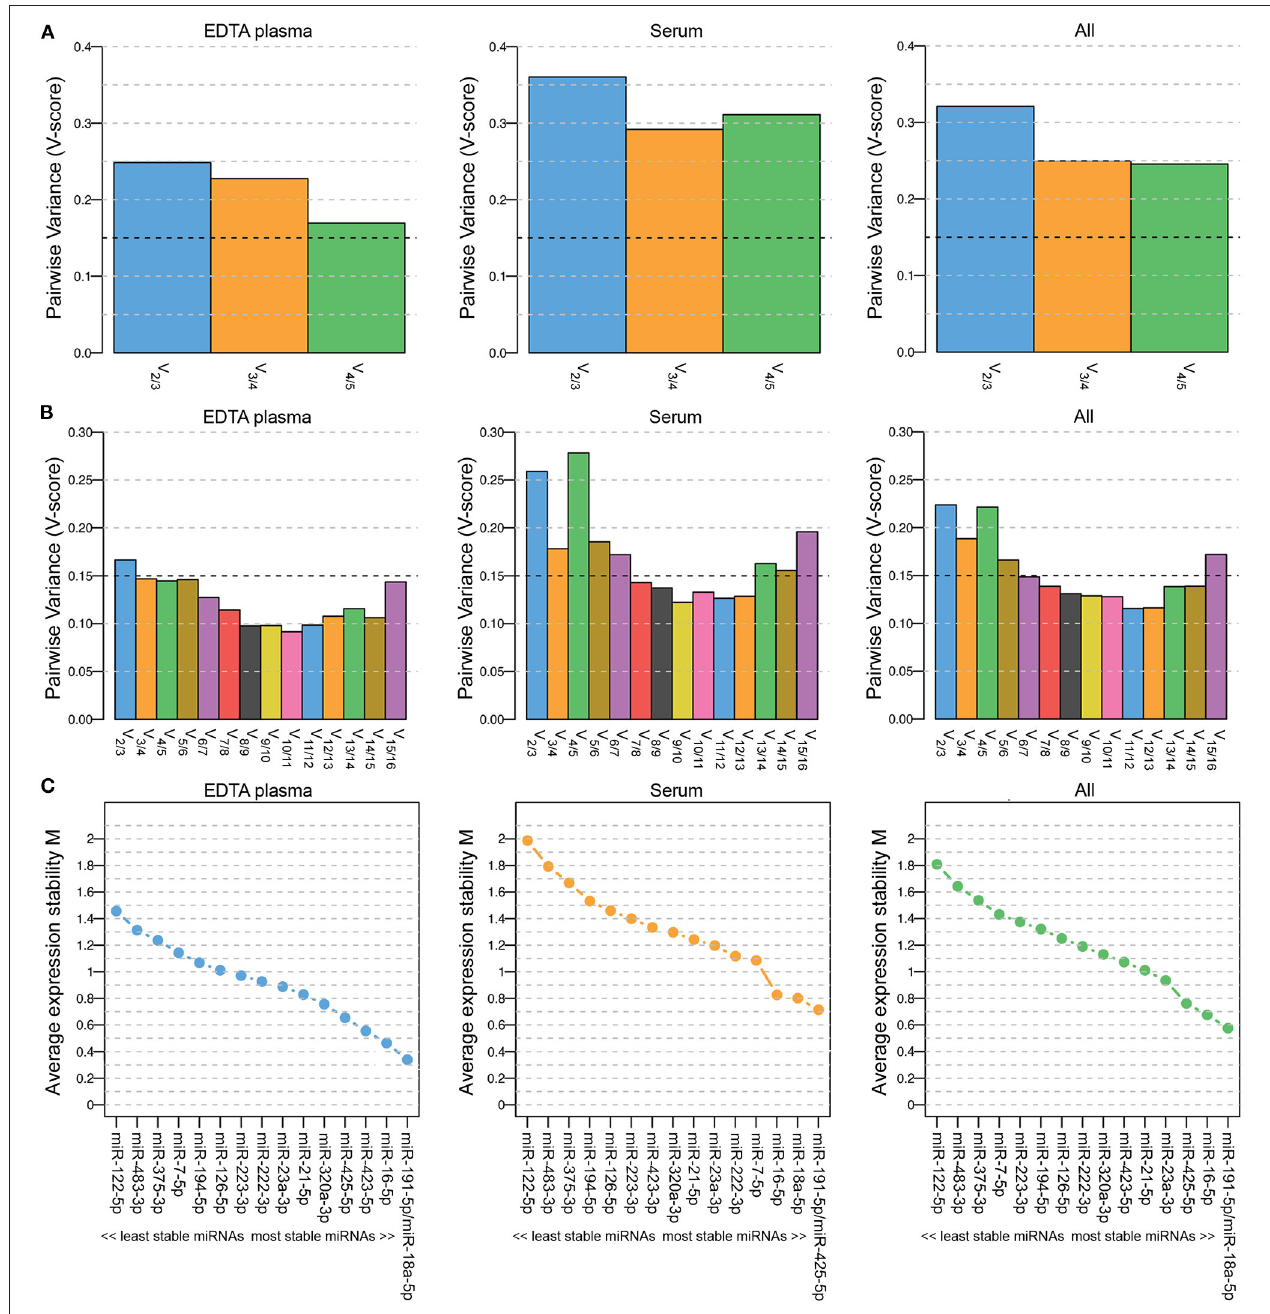
FIGURE 1 | Pairwise Variance (V-score) (A,B) and Average expression stability M (C) of miRNAs included in geNorm analyses to determine the optimal number of miRNAs for data normalization. Results when including 5 ( A ; miR-23a-3p, miR-191-5p, miR-222-3p, miR-423-5p and miR-425-5p) and when including 16 ( B,C ; miR-7-5p, miR-16-5p, miR-18a-5p, miR-21-5p, miR-23a-3p, miR-122-5p, miR-126-5p, miR-191-5p, miR-194-5p, miR-222-3p, miR-223-3p, miR-320a-3p, miR-375-3p, miR-423-5p, miR-425-5p and miR-483-3p) miRNAs. Left panels (EDTA plasma) include samples from healthy dogs ( n = 6) and from dogs with pituitary-dependent hypercortisolism ( n = 19, pre-op and post-op samples); middle panels (serum) include samples from healthy dogs ( n = 6) and from dogs with cortisol-secreting adrenocortical tumors ( n = 26); right panels (all) include both EDTA plasma and serum samples ( n =